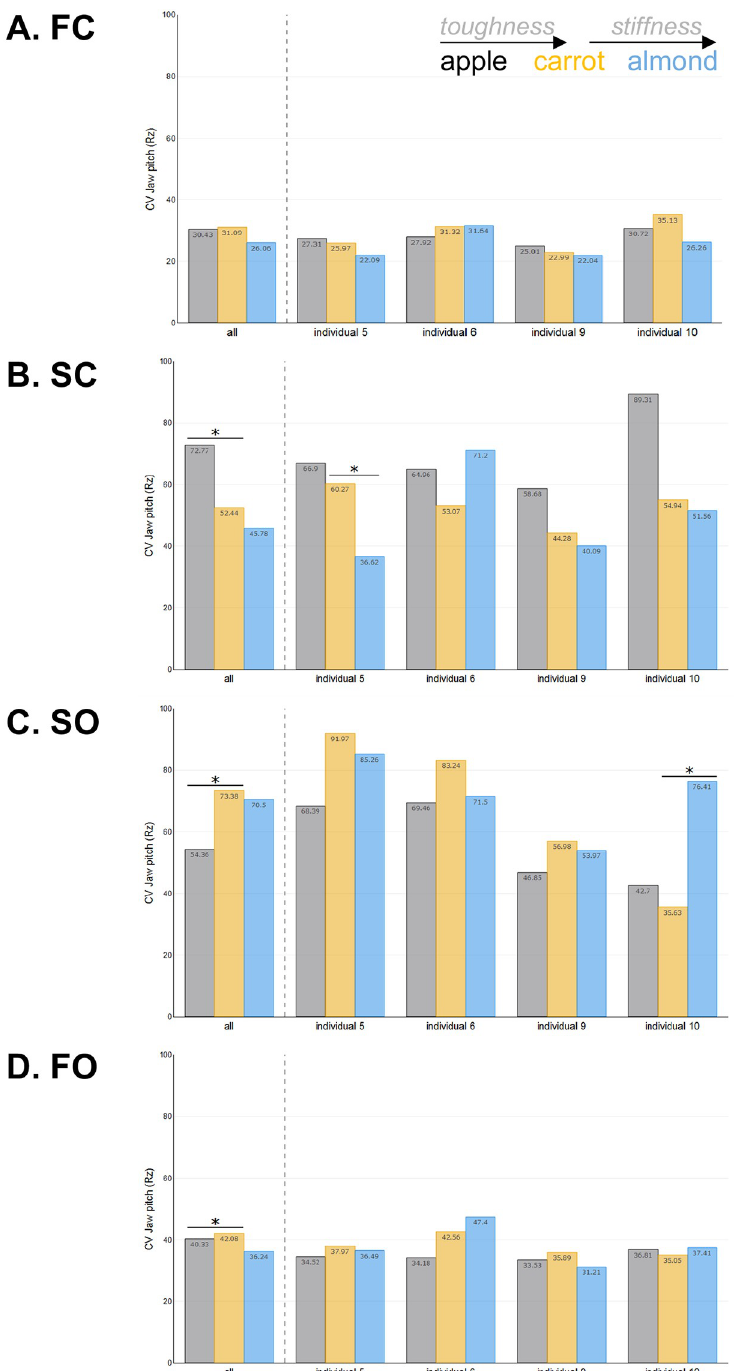
Fig 5. Effect of food toughness and stiffness on the within-food variability of jaw pitch amplitude. CV indicates the level of stereotypy in the amplitude of Rz for each food during each phase: A ) FC, B ) SC, C ) SO and D ) FO. Colors represent foods: apples in black, carrots in orange and almonds in blue. Significant differences between foods are indicated by an � .